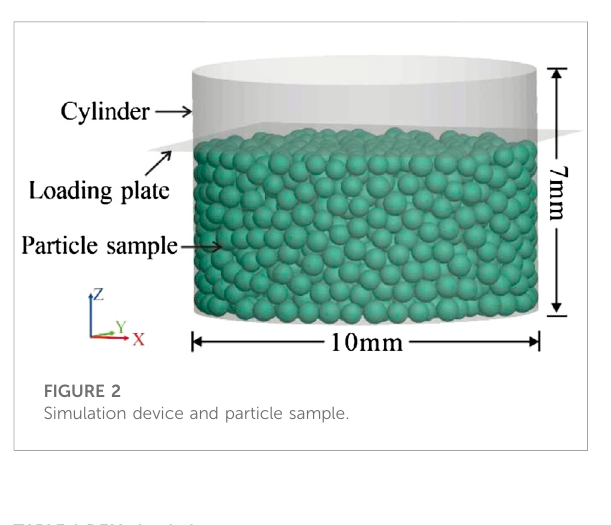
TABLE 1 DEM simulation parameters.